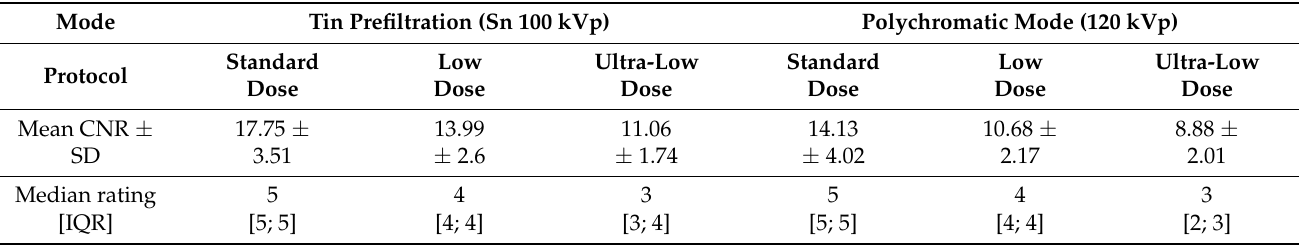
Table 3. Summary of objective and subjective image quality